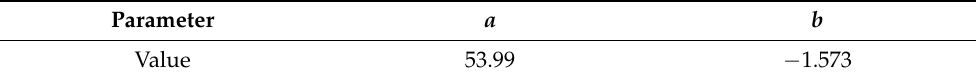
Table 6. Correlation parameter between RC Network first time constant and SOC.